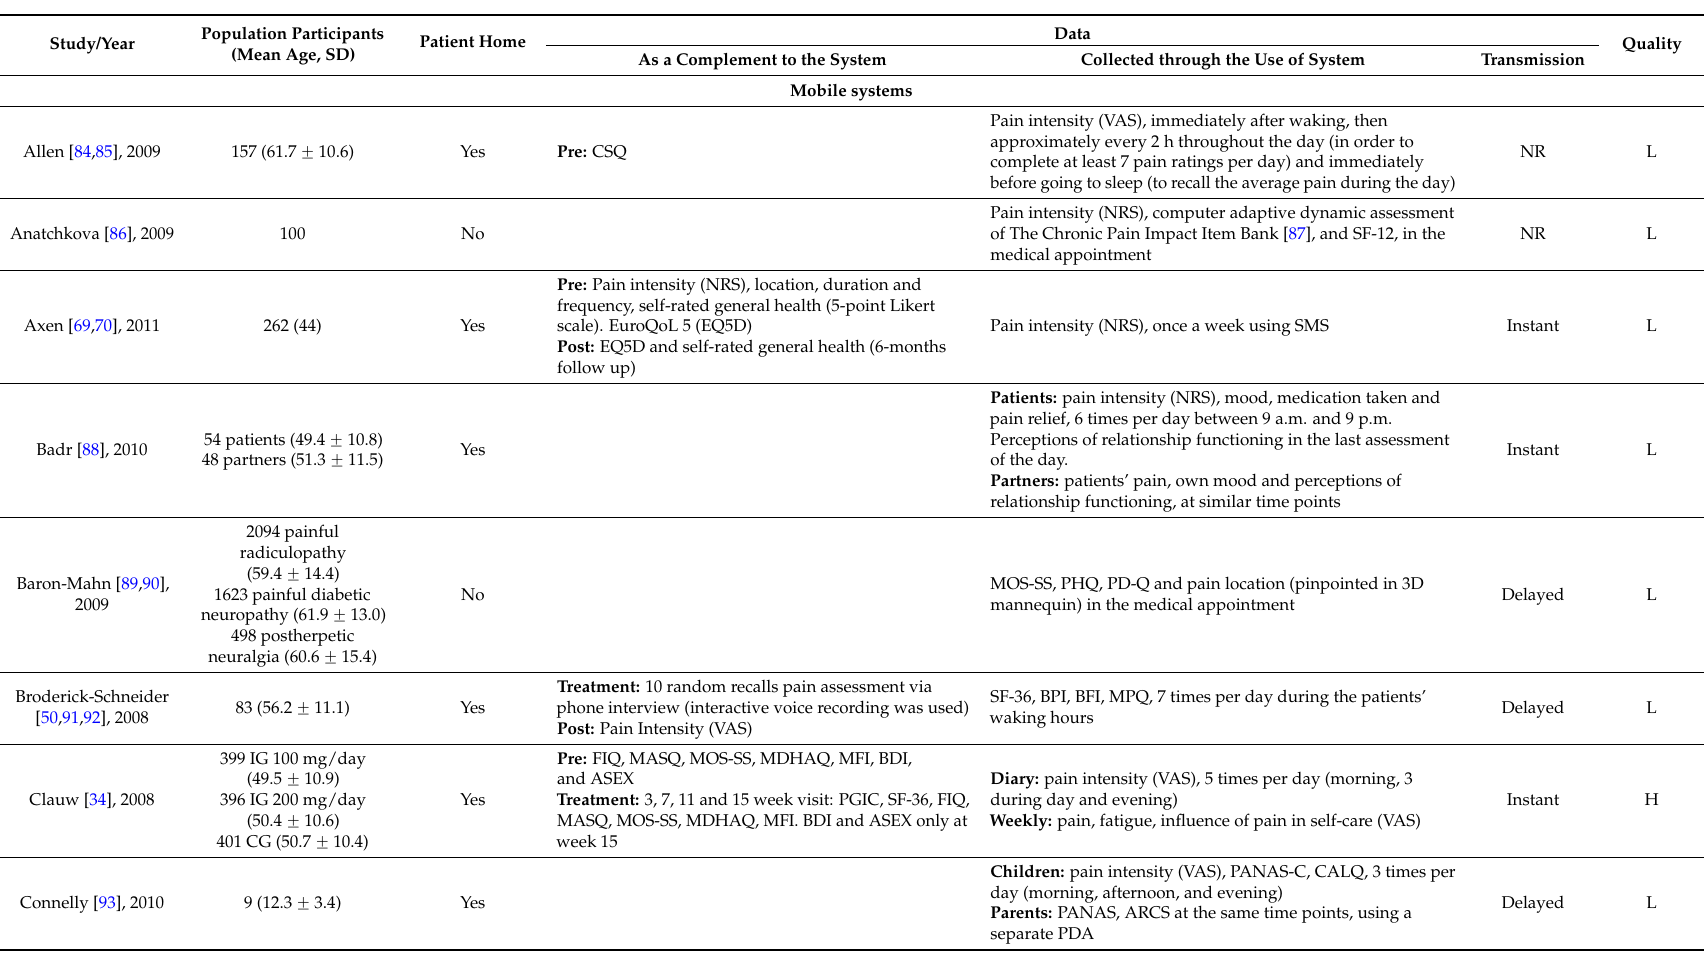
Table A1. Studies